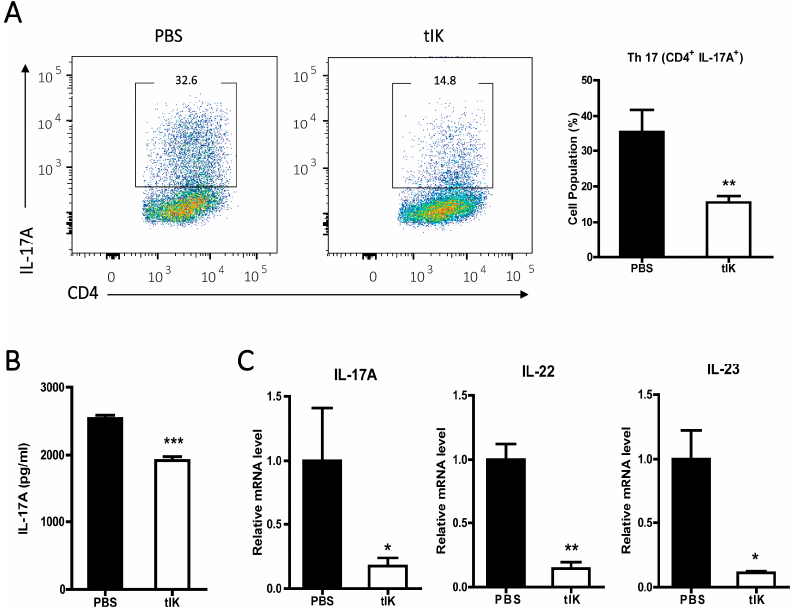
Figure 2. Treatment of naïve CD4 + T cells with tIK protein suppresses their differentiation into Th17 cells. ( A ) CD4 + T cells isolated from 7-week-old Balb/c mice using magnetic activated cell sorting were cultured in Th17-polarizing medium. After 3 days, the differentiated cells were collected and stained with anti-CD4-APC and anti-IL-17A-PE for analysis using flow cytometry. The pseudo-color dot plots represent cell distribution in CD4 + T cells and the cells gated in the box express IL-17. Therefore, the cells in the box are Th17 cells (CD4 + IL-17A + ). The mean percentages of Th17 cells are shown by the black bar graph; ( B ) Stimuli (anti-CD3 and anti-CD28 antibodies (each 1 μ g/mL)) were added to the Th17-differentiated cells. After 24 h incubation, the culture supernatant was harvested and the concentration of IL-17A in the supernatant was quantitated using ELISA; ( C ) The mRNA levels for IL-17, IL-22 and IL-23 in the Th17-differentiated cells shown in Figure 2A were analyzed by qPCR. All experiments were independently repeated three times. Data is represented as the mean ± SD ( n = 3), * p < 0.05, ** p < 0.005, *** p < 0.001.